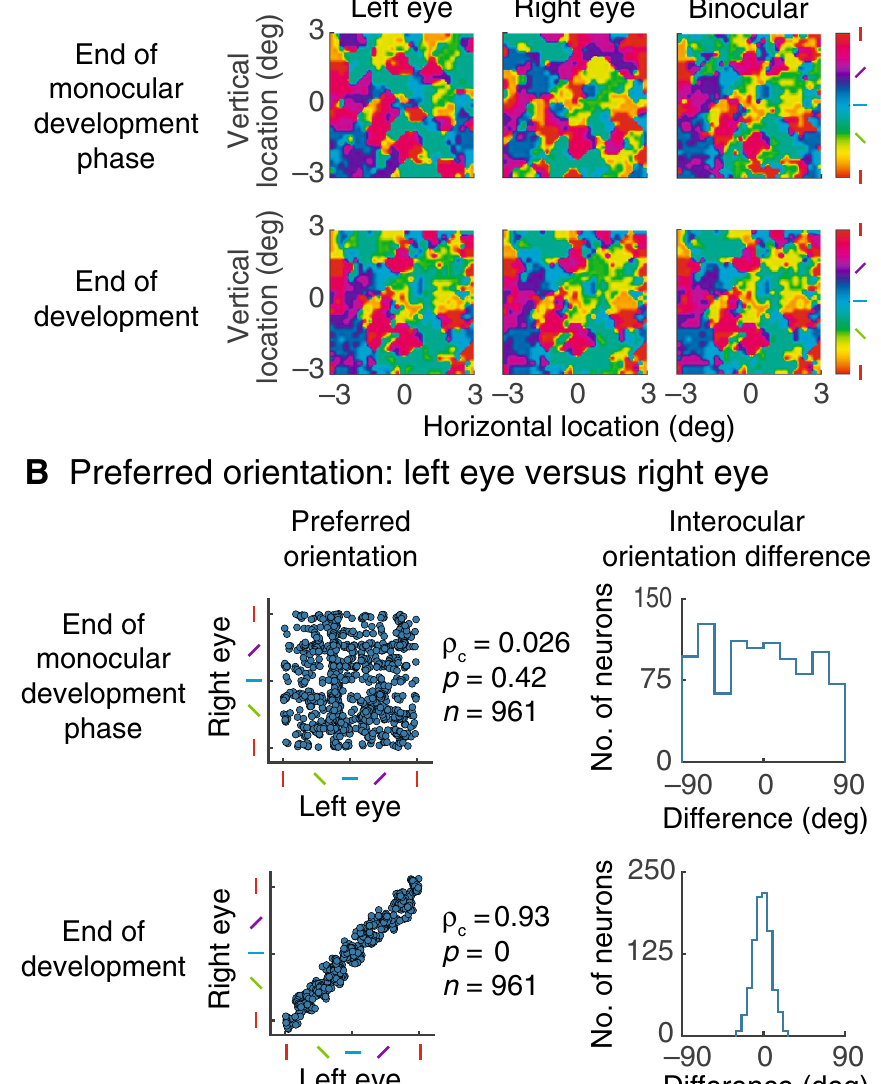
Figure 5. Binocular development across the neuronal population. ( A ) Orientation tuning was measured for all (excitatory) cortical cells and the preferred orientations are colour coded for each visual field location. The colour key is shown at the right. There is no match between orientation preference for left and right eye stimulation at the end of the monocular development phase (upper row). The map resulting from binocular stimulation, shown at right, contains elements of both monocular plots. By the end of the second development phase the left and right eye maps are very similar, as shown in the lower row. As expected, binocular stimulation at the end of development (right plot) gives a map that is like both the monocular plots. ( B ) This shows interocular matching of orientation preference. The left side shows, on the horizontal and vertical axes, preferred orientation for stimuli delivered to the left and right eye respectively; each neuron is represented by a single dot. At the end of the monocular phase of development (upper row) there is no clear interocular relationship. Correspondingly the histogram (at right), which gives the difference between left and right eye preferred orientations, is essentially flat. At the end of the binocular development phase (lower row) left and right eye orientation preferences are now similar (left graph) and the histogram of interocular orientation difference (right graph) deviates little from